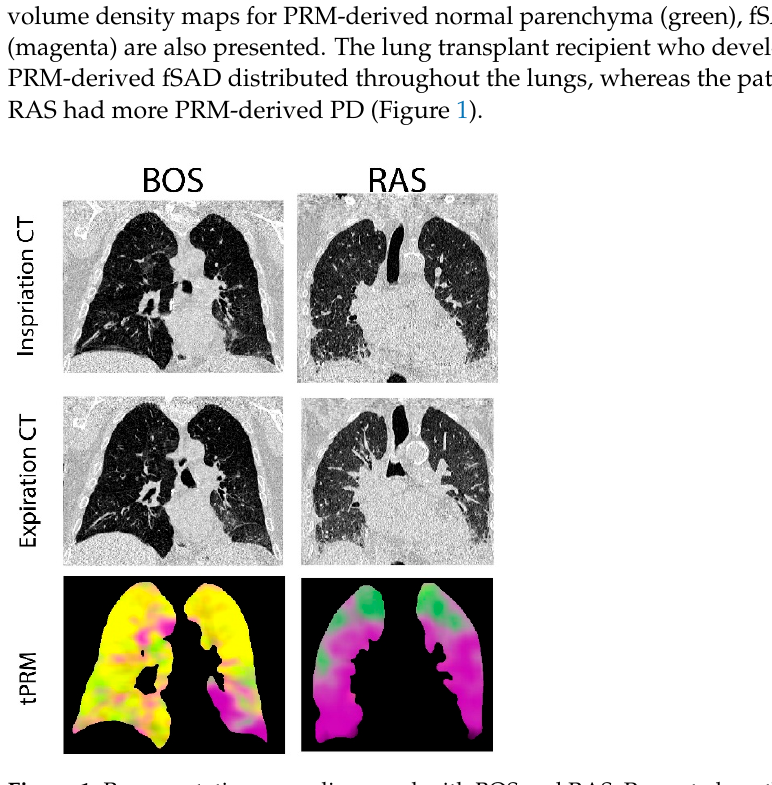
Figure 1. Representative cases diagnosed with BOS and RAS. Presented are the coronal view of CT scans acquired at inspiration and expiration with corresponding topological parametric response mapping (tPRM)-derived volume density maps for normal parenchyma (green), functional small airways disease (fSAD; yellow) and parenchymal disease (PD; magenta).